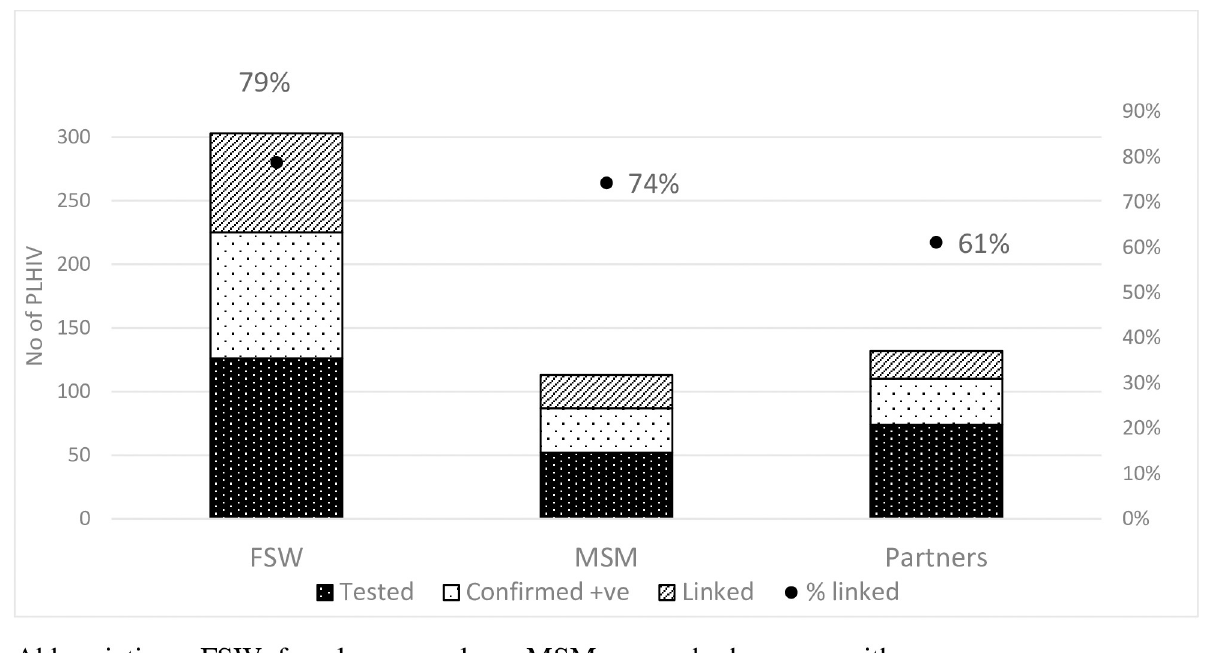
Fig 2. Linkage to care of recipients who tested HIV positive through use of HIV self-test kits (HIVST) in Kampala, Uganda (October 2018–June